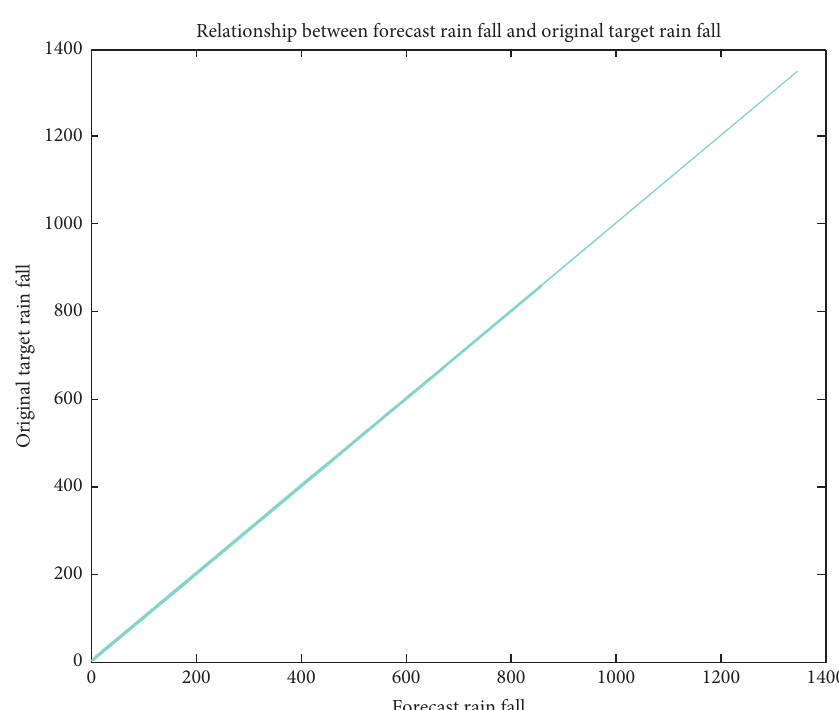
Figure 13: Relationship between forecast rainfall and original target